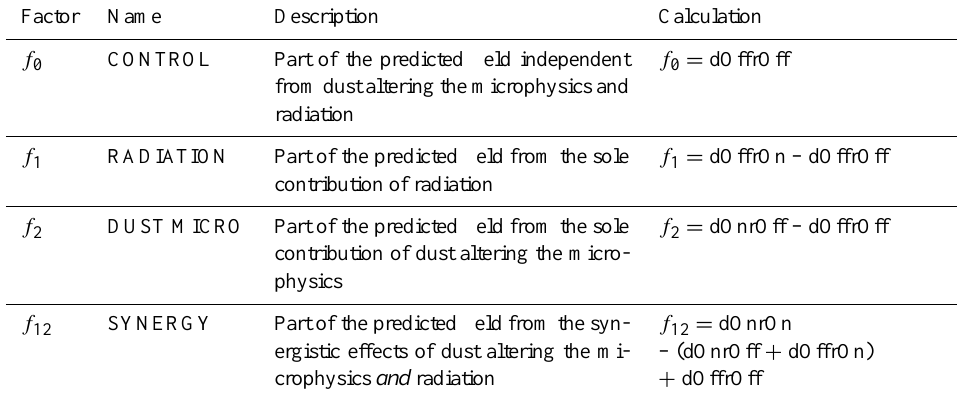
Table 3. The components and naming convection of the factor separation analysis.